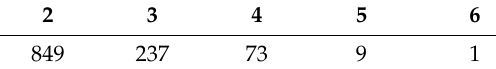
Table 5. FFCI distribution historical flood events in